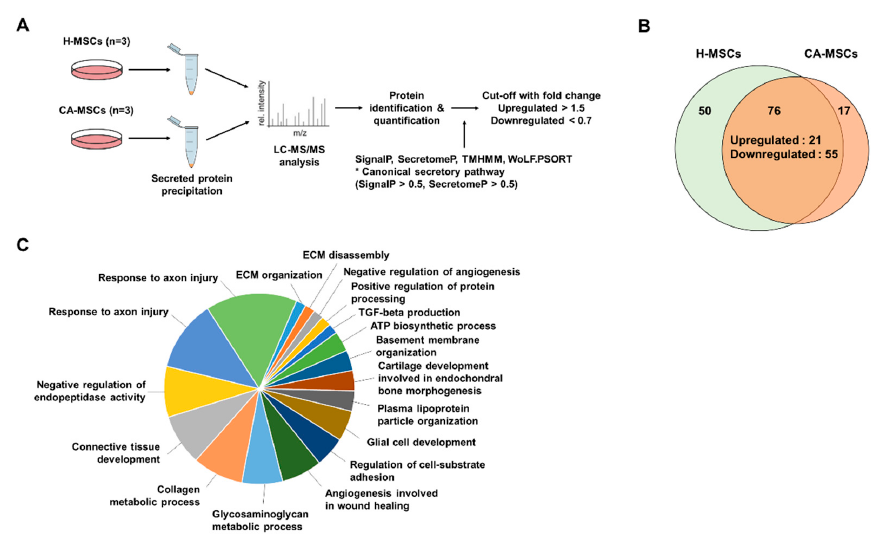
Figure 4. Characteristics of the secretome of MSCs derived from CA-MSCs. ( A ) Schematic drawing of the secretome analysis procedure. ( B ) Venn diagrams showing the number of identified proteins in the secretome of MSCs derived from healthy individuals (H-MSCs) and CA-MSCs. Overall, 50 proteins are exclusively identified in H-MSCs, 17 are identified in CA-MSCs, and 76 are identified in both MSCs. ( C ) Pie chart illustrates the functional analysis using the biological processes of the downregulated secretome in CA-MSCs.